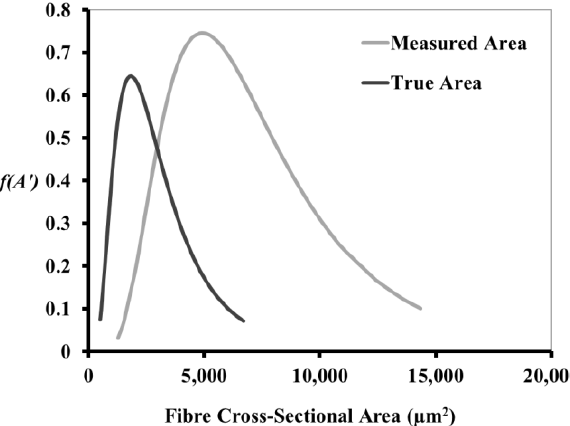
Table 2. The fibre area correction factor K determined using Equation (3) was 2.70.